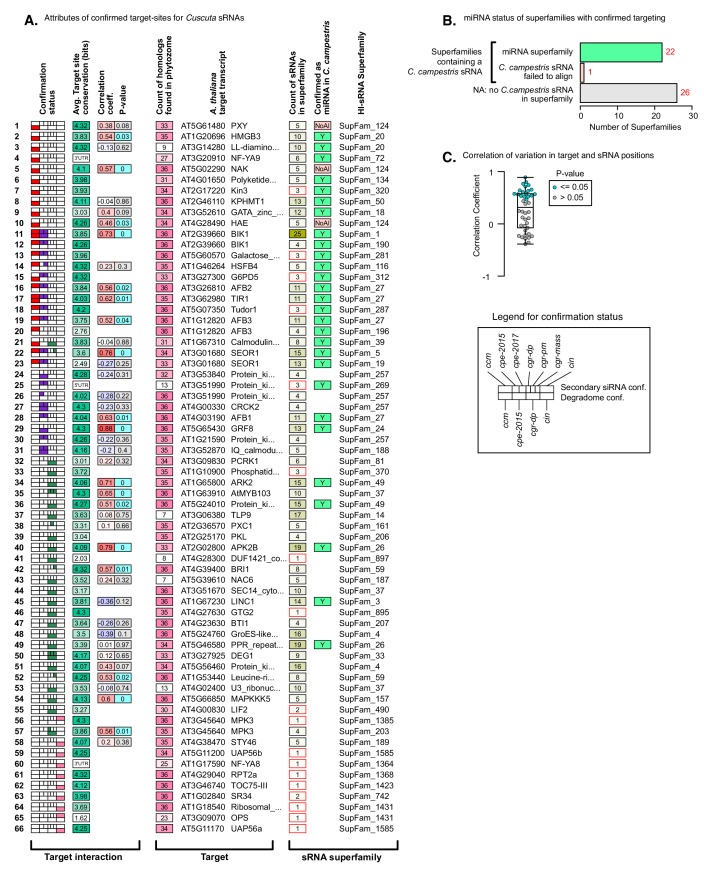
Summary of Cuscuta HI-sRNA and host gene target relationships.(A) Complete list of target interactions between sRNAs and host genes. Confirmation status diagram indicates in what species the interaction is confirmed. Target gene information includes the number of homologs found in 36 eudicot transcriptomes. sRNA counts in superfamilies and the presence of a confirmed miRNA in the family is shown (NoAl: ccm sRNA failed to align to ccm genome). Target interaction columns indicate the conservation at the translated target site in an alignment of found homologs (5’/3’ UTR: not considered for conservation analysis). Correlation coefficient and P-value for variation in positions in target and sRNA superfamily shown. (B) Breakdown of superfamilies with confirmed targeting by the presence of a confirmed miRNA, where possible. (C) Correlation of positional variation in target-sites and their sRNAs, indicating the interactions with a significant correlation.